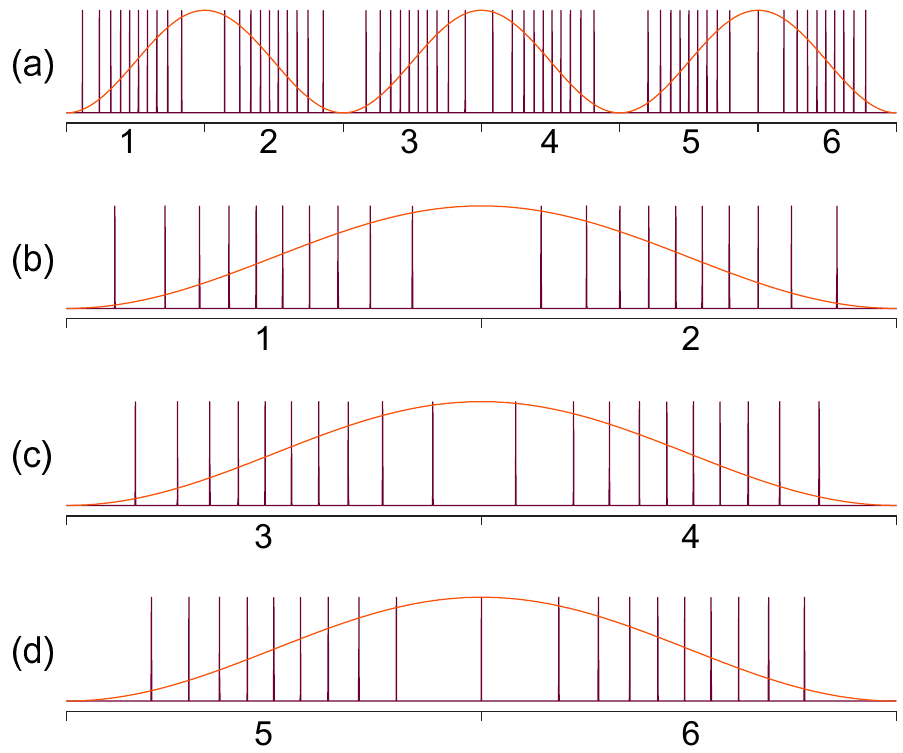
Figure 14. The principle of discrete frequency domain harmonic mode-locked laser with reconfigurable uniform comb lines. ( a ) Six independent pulse train groups with the forward and backward sweeps in three sub-periods, ( b – d ) are the three sub-periods with bi-directional sweeps, where the relative shift of the comb lines is shown. Reprinted with permission from Ref. [95].